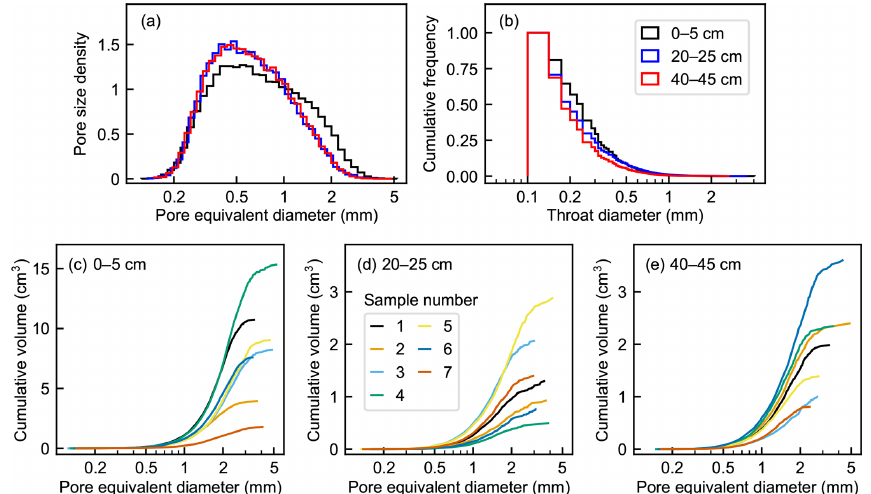
Figure 6. Pore size characteristics of the 600 3 -voxel domain pore networks from the sampling depths of 0–5, 20–25, and 40–45cm. (a) Com- bined histograms of the probability density functions of pore size. (b) Combined cumulative relative frequency histograms of throat diameters. (c–e) Cumulative volume distribution of each pore network in relation to pore equivalent